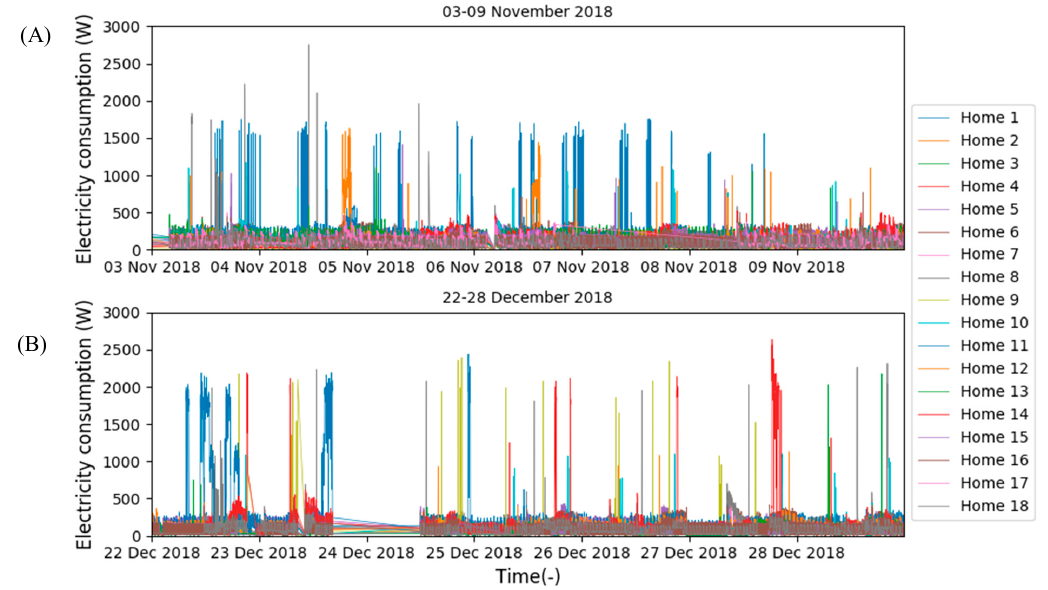
Figure 4. ( A ) Electricity consumption from 3–9 November 2018; ( B ) Electricity consumption from 22–28 December